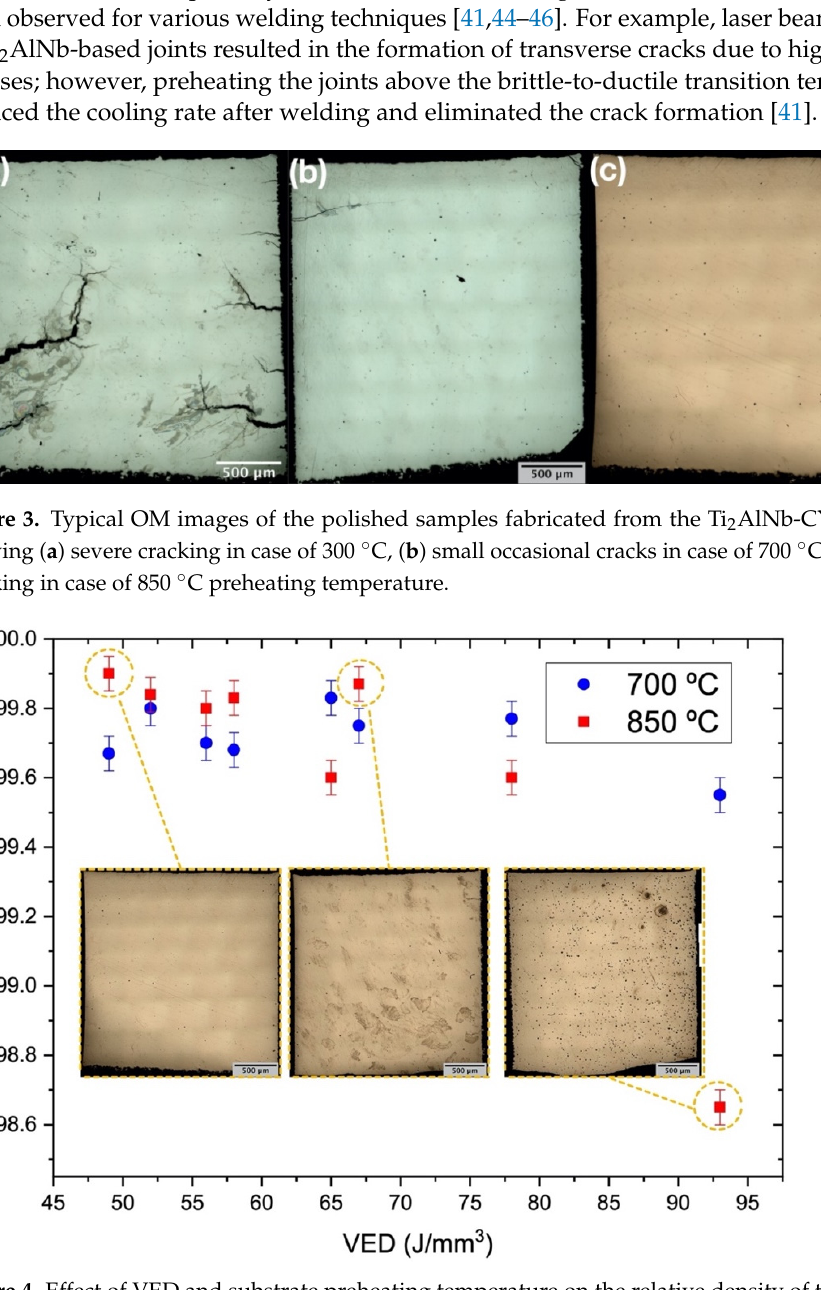
Figure 4. Effect of VED and substrate preheating temperature on the relative density of the samples fabricated from the Ti 2 AlNb-CYB powder. The insets show the representative OM images of the polished samples corresponding to different VED values.